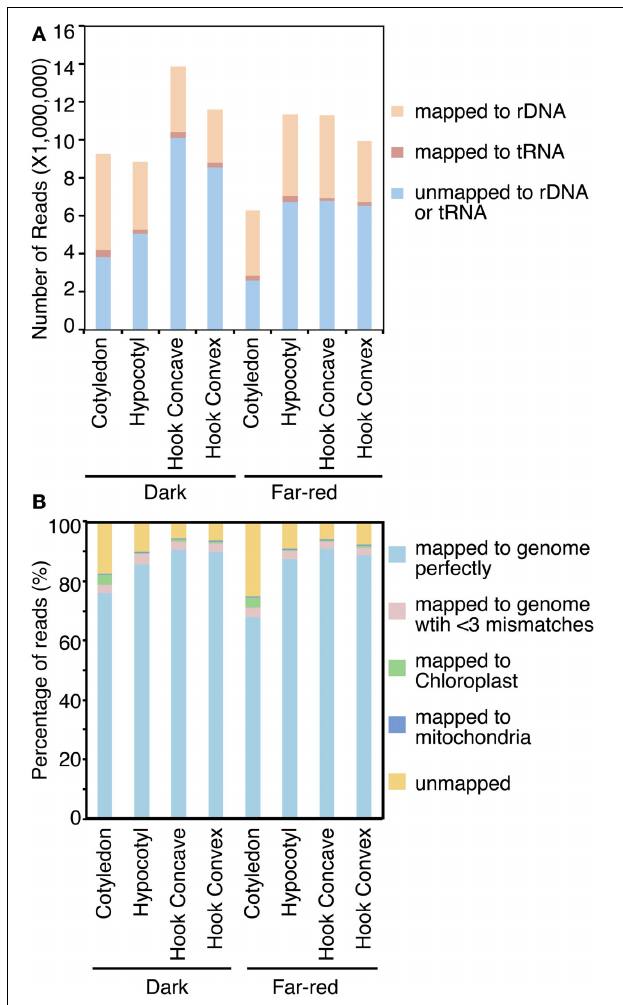
FIGURE 2 | Abundance of small RNA mapping to soybean genome. Small RNA reads were first aligned to soybean tRNA and rDNA to filter these types of noncoding RNA (A) . Reads which passed this filter were then aligned to the soybean nuclear and plastid genomes (B) .